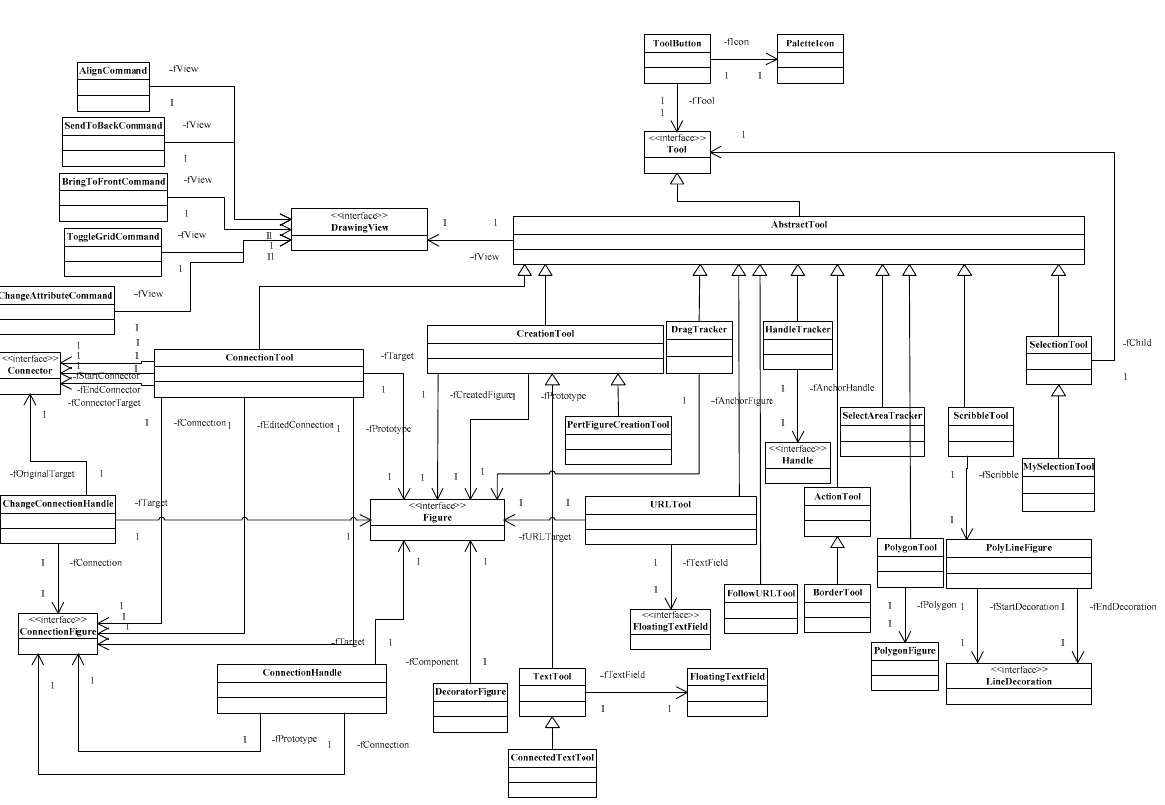
Figure A1. UML class diagram of Subsystem of the open source project JHotDraw 5.1.